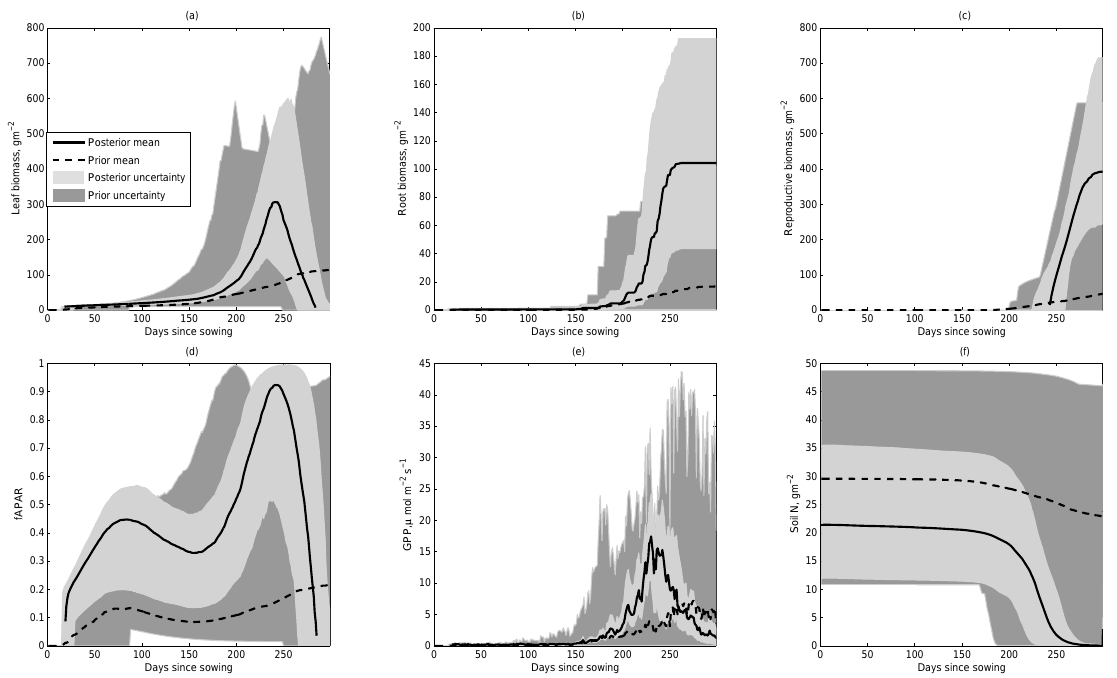
Figure 1. Comparison of prior model predictions (dark grey, dashed line) and posterior model predictions (light grey, continuous line) at one wheat (DK-Ris) site. Panels show (a) aboveground biomass, (b) belowground biomass, (c) reproductive biomass, (d) fAPAR, (e) GPP and (f) soil